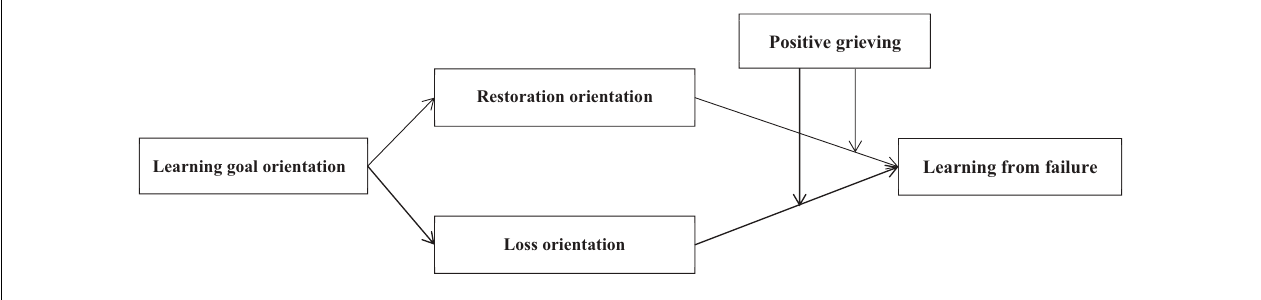
FIGURE 1 | Theoretical